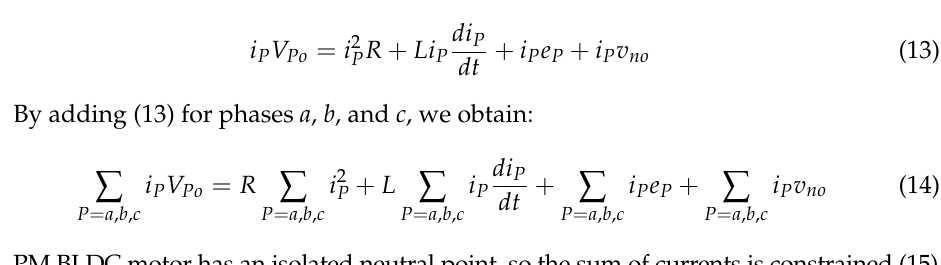
PM BLDC motor has an isolated neutral point, so the sum of currents is constrained (15).